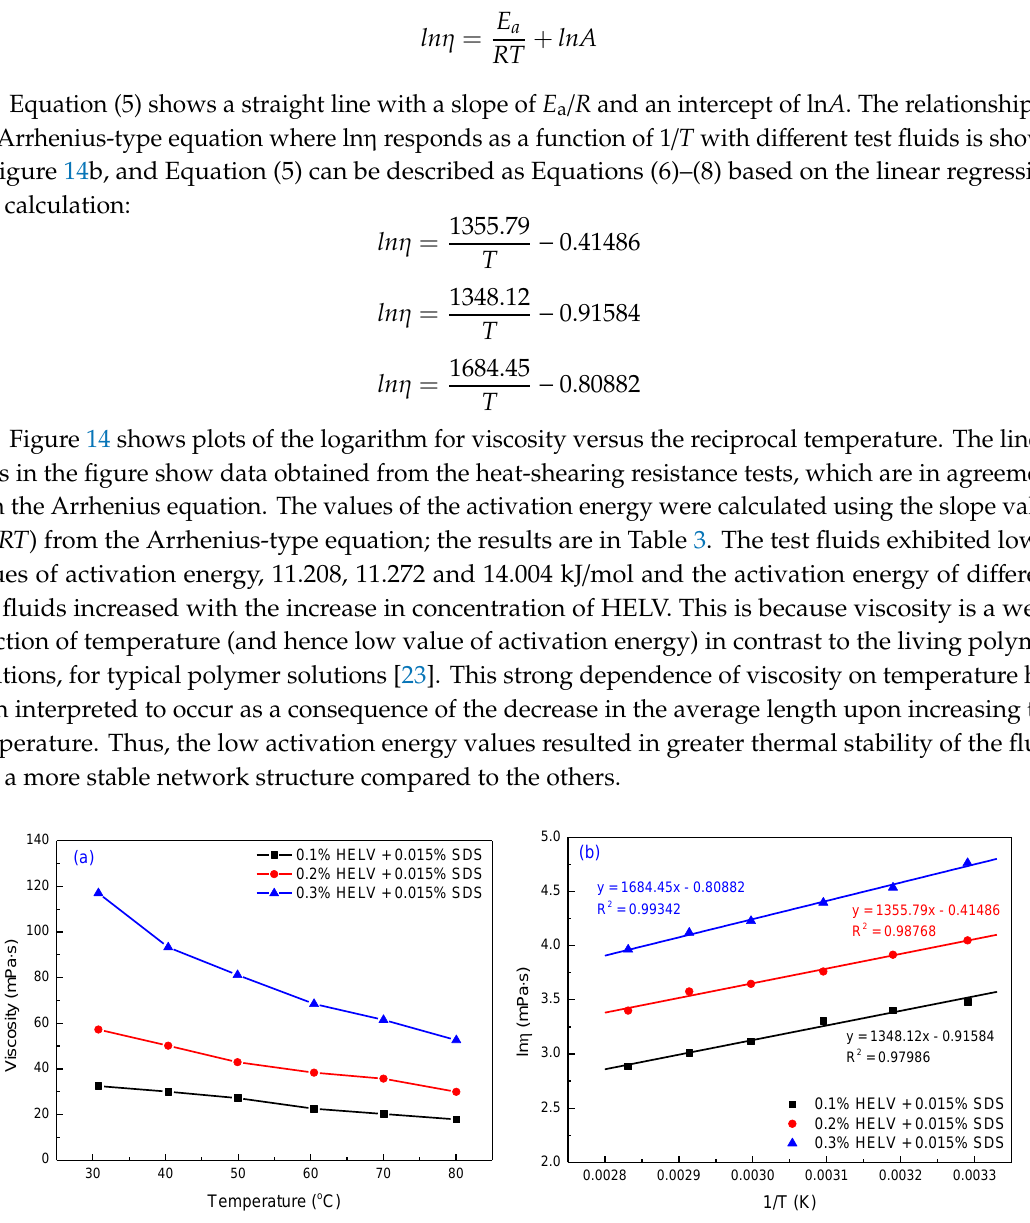
Figure 14. Heat-shearing resistance test and thermodynamics: ( a ) heat-shearing resistance of test fluids; ( b ) thermodynamic data of test fluids. Table 3. Values of the activation energy of test